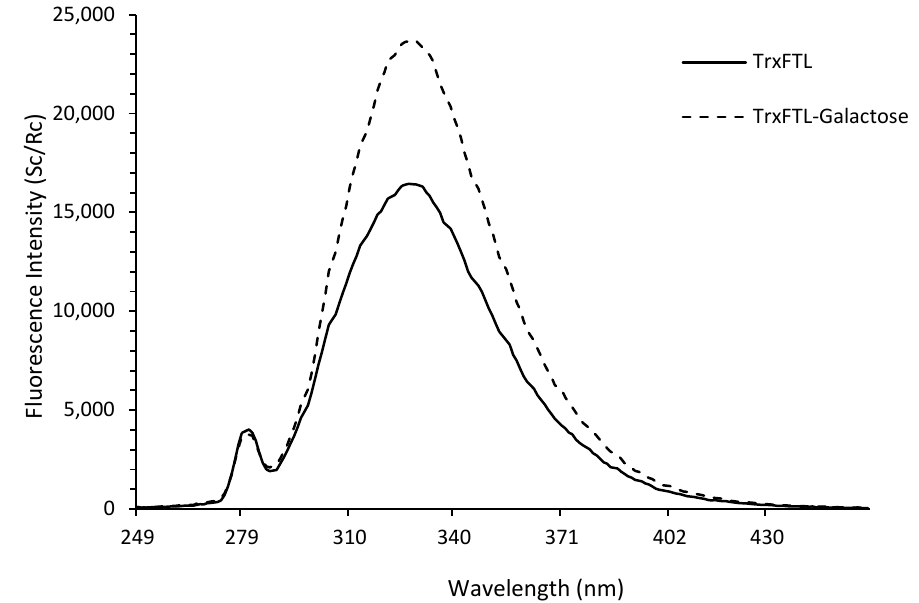
Figure 5. Fluorescence emission spectra of TrxFTL in the absence (solid line) and presence (dashed line) of methyl- α -galactose in PBS.